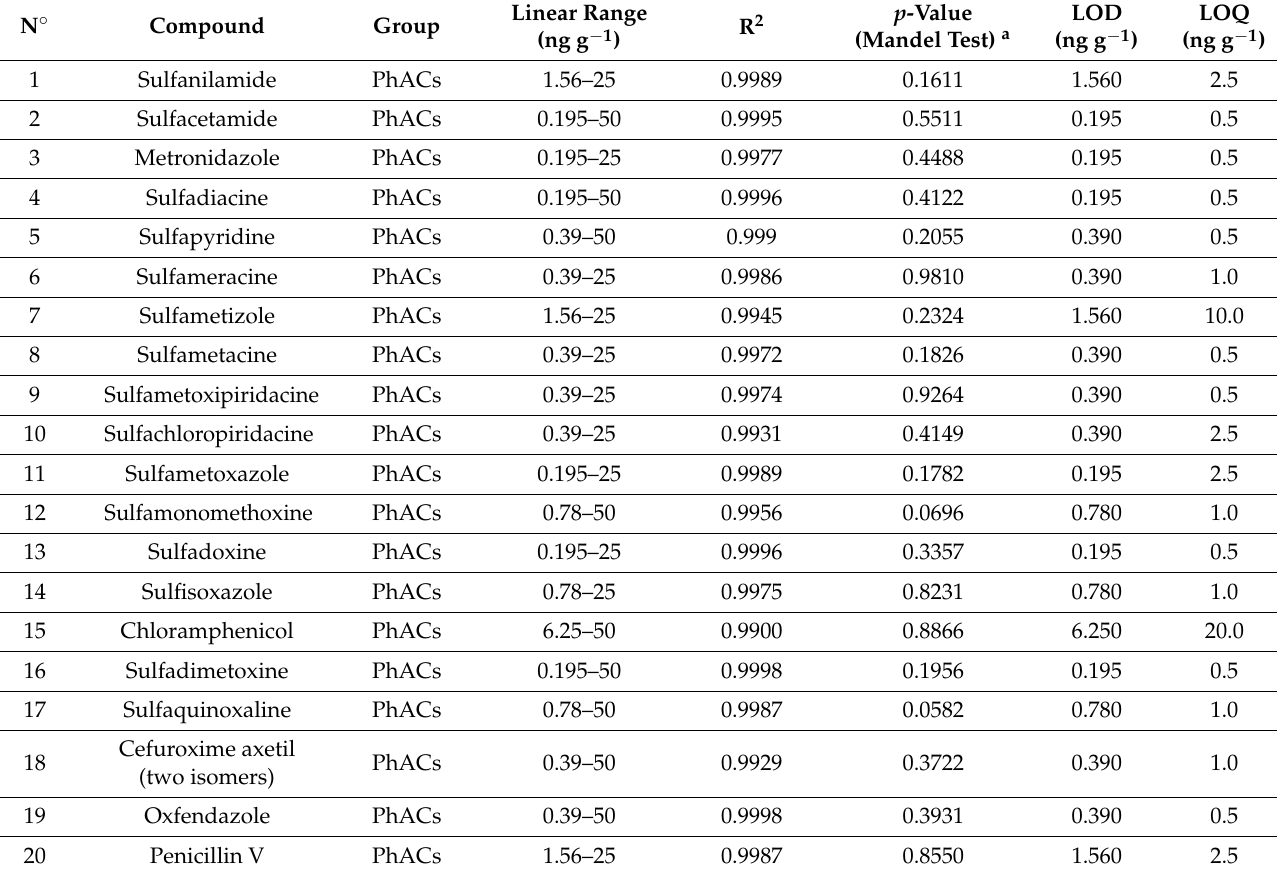
Table 2. Linear studies and threshold limits of the ARs and